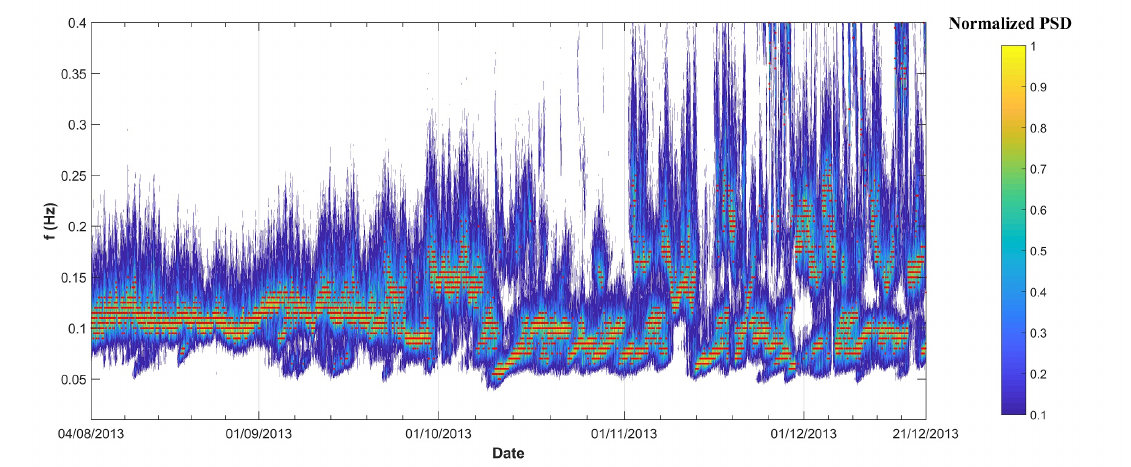
Figure 6. Temporal variability in the normalized spectral energy density during the observed period (computed from half-hourly data). Spectral energy values normalized with respect to peak energy density. Red dots are located at the peak